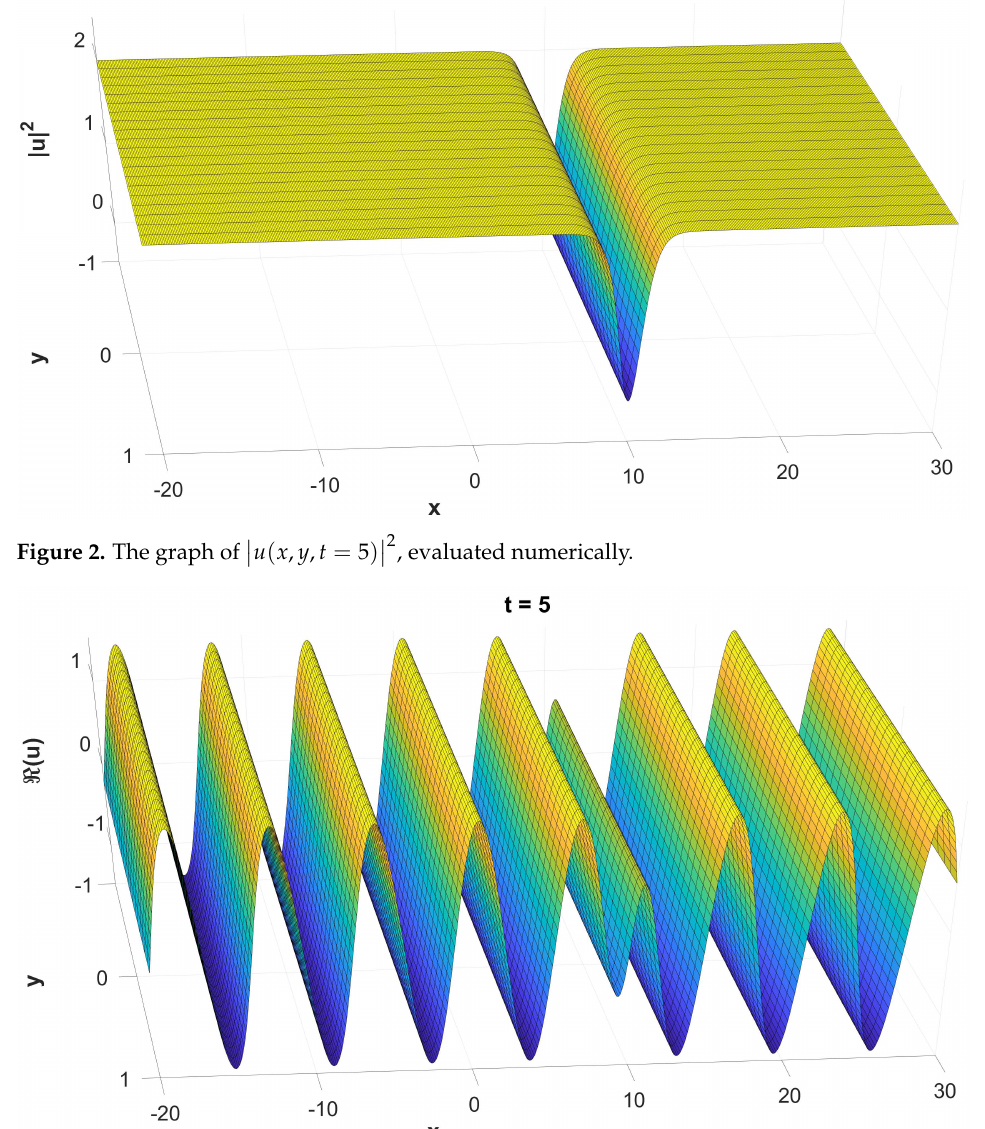
(cid:0) (cid:1) u ( x , y , t = 5 ) , evaluated